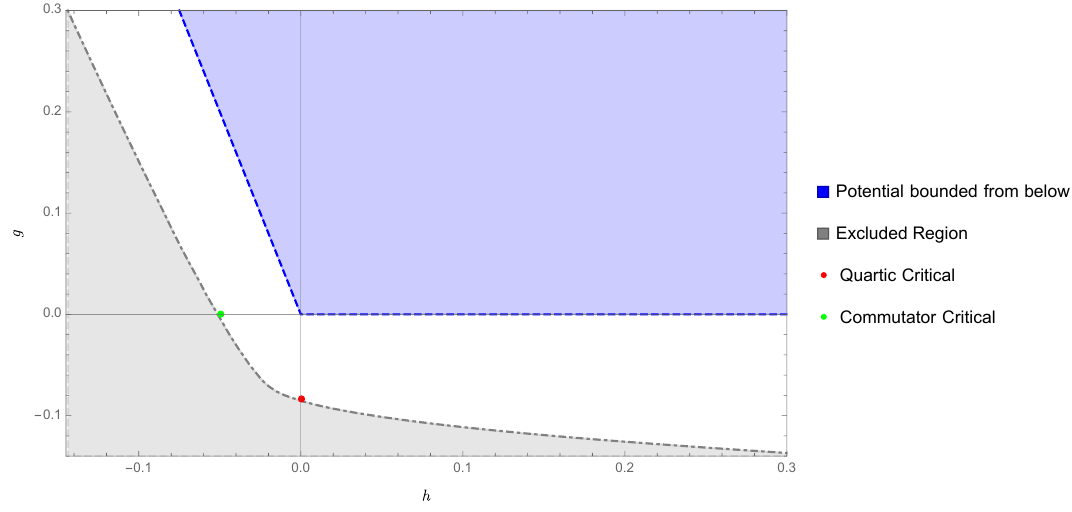
Figure 7 . The numerical phase diagram of the model (5.1). The gray region is strictly excluded by our relaxation bootstrap method at Λ = 8 . In the blue region the matrix potential is bounded from below and its boundary is located above the straight lines g = 0 and h = − 1 green dots are the critical valus for h = 0 and g = 0